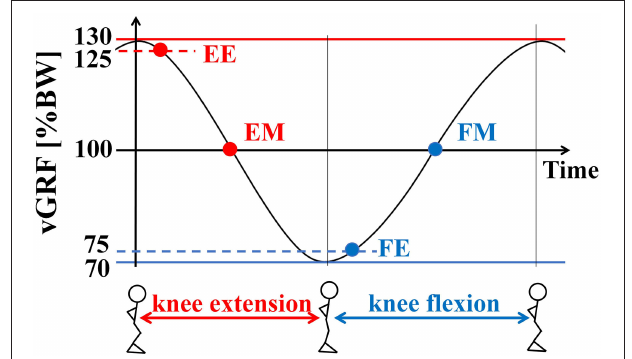
FIGURE 2 | Visual cue presentation timing in the P condition. Real-time visual feedback of the vertical GRF (vGRF) was provided with the monitor behind the LEDs, and the subjects were asked to maintain the vGRF from 70 to 130% of their body weight (BW), followed by the sidestepping reaction task. The reaction signal was provided at the following four different loading instants while performing the preparatory movement: when the vGRF first fell below 125 and 100% BW during the knee extension phase (early phase: EE, and middle phase: EM), and when the vGRF first exceeded 75 and 100% BW during the knee flexion phase (early phase: FE, middle phase: